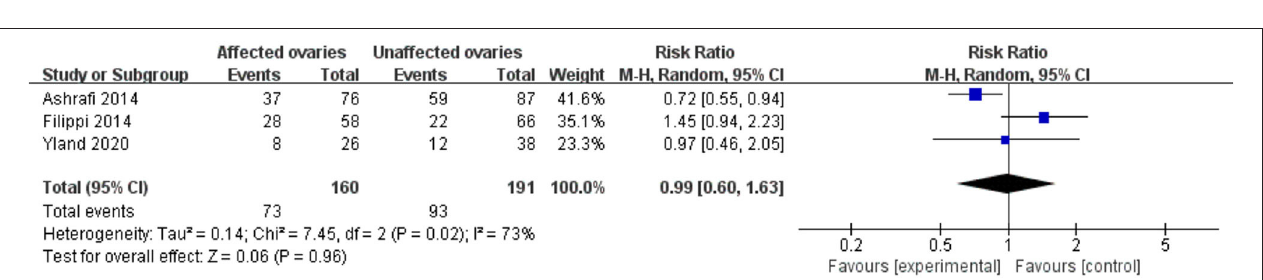
FIGURE 5 | Forest plot of high-quality embryo rate for affected ovaries vs. unaffected